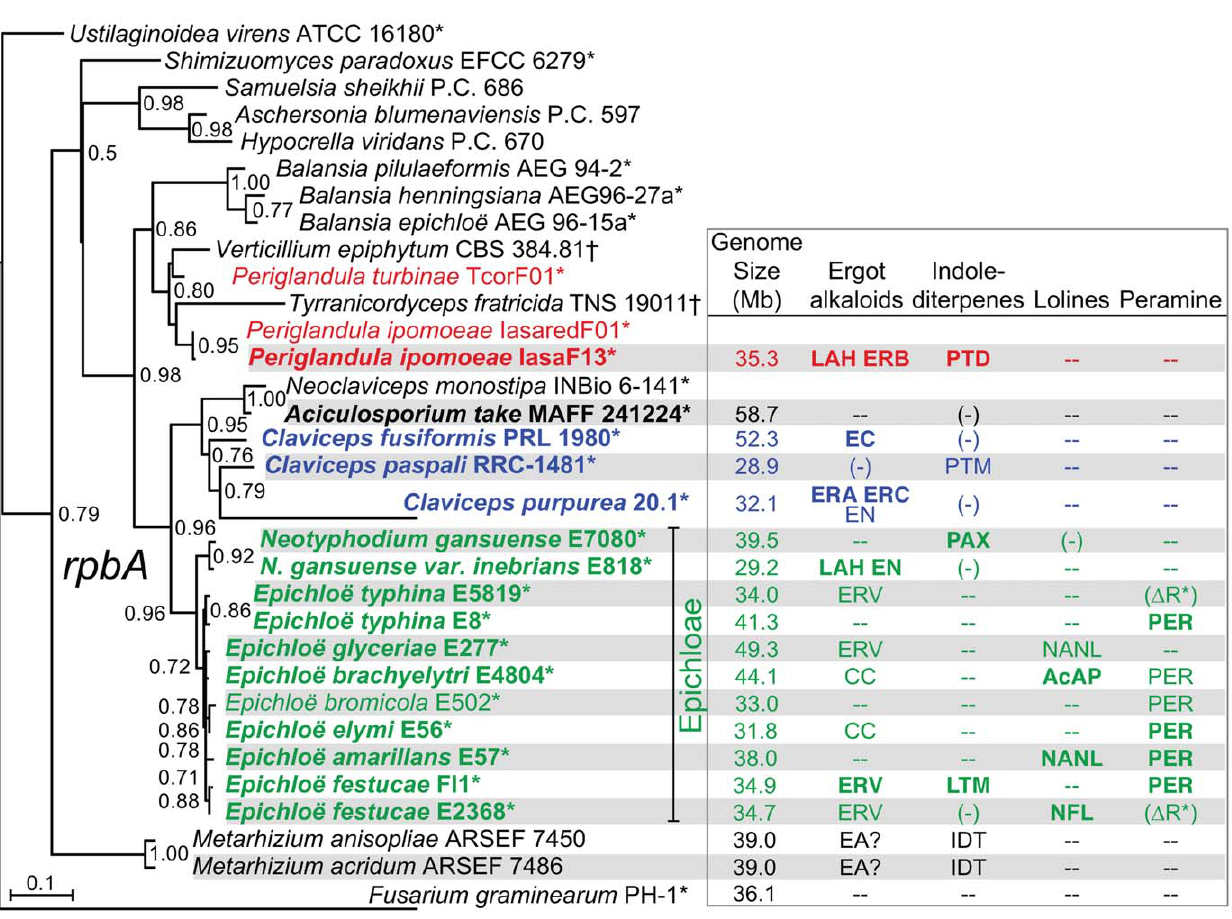
Figure 5. Phylogenies of rpbA from sequenced isolates and other Clavicipitaceae. The phylogenetic tree is based on nucleotide alignment for a portion of the RNA polymerase II largest subunit gene, rpbA . This tree is rooted with Fusarium graminearum as the outgroup. Epichloae are indicated in green, Claviceps species are indicated in blue, Periglandula species are indicated in red, and Aciculosporium take is in black. Species for which genomes were sequenced in this study are shown in bold type, and asterisks indicate plant-associated fungi. Alkaloids listed are the major pathway end-products predicted from the genome sequences, abbreviated as shown in Figure 2, Figure 3, Figure 4. Other abbreviations: ( 2 )=some genes or remnants present, but not predicted to make alkaloids of this class, –=no genes present for this alkaloid class, EA=ergot alkaloids may be produced; IDT=indole-diterpenes may be produced, ( D R*)=deletion of terminal reductase domain of perA .